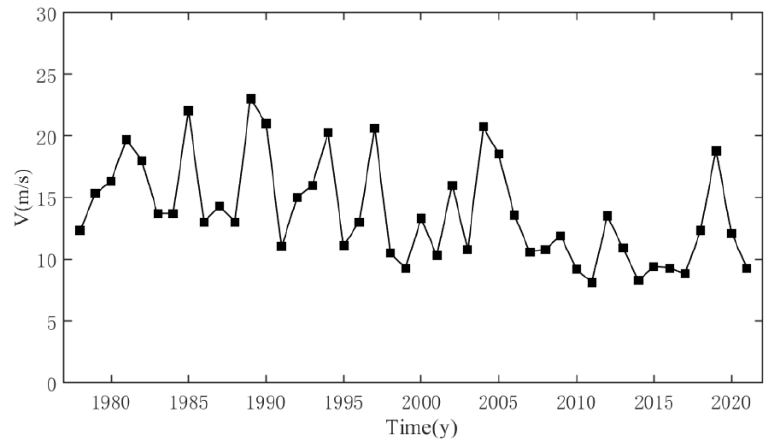
Figure 3. Annual maximum wind speed series of Hongjia station from 1978 to 2021.